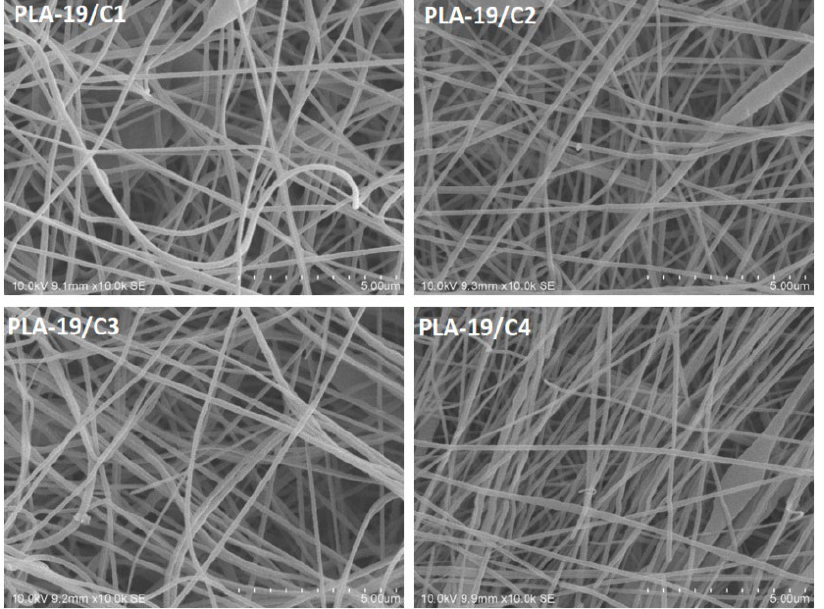
Figure 5. SEM images of 19% PLA nanofibers with variations in CNDs of 1, 2, 3, and 4% (scale — 5